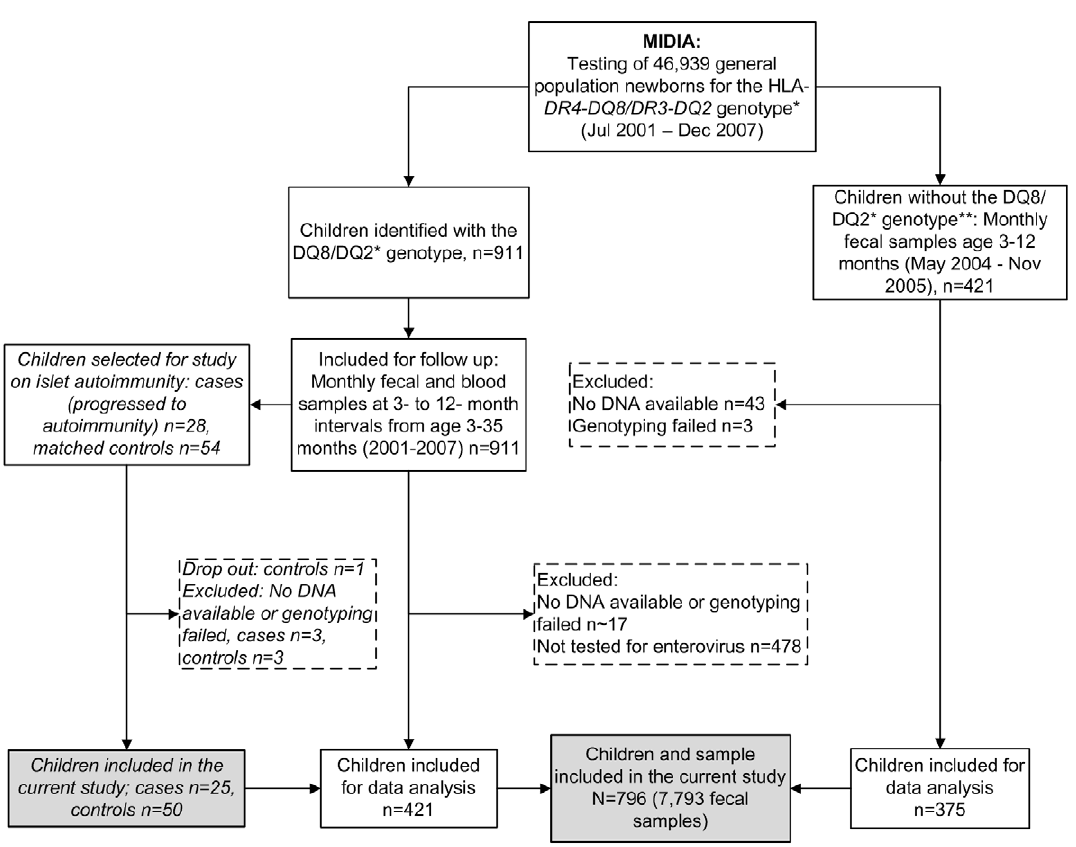
Figure 1. Flow chart illustrating the details of inclusion of children and samples in the current analysis. * HLA - DRB1*04:01-DQA1*03- DQB1*03:02/DRB1*03-DQA1*05-DQB1*02 ( DR4-DQ8/DR3-DQ2 ), conferring high risk for type 1 diabetes. **For each child identified with the high-risk genotype, about 1–4 children without the high risk genotype were enrolled from the same county.